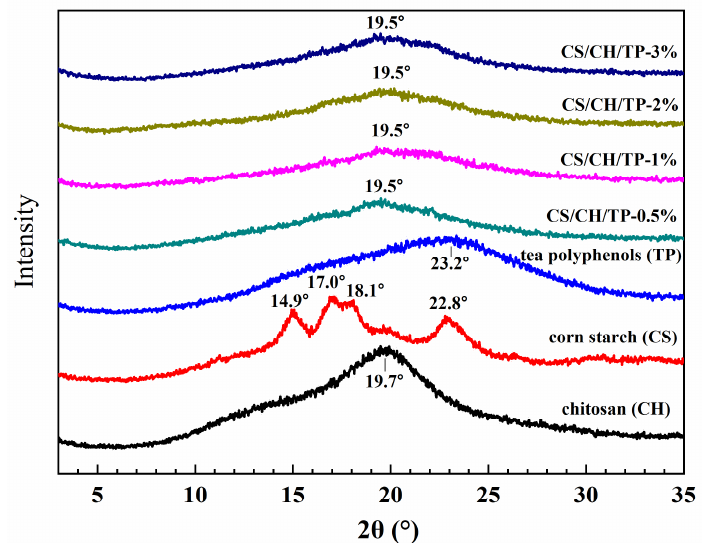
Figure 3. X-ray diffraction patterns of CS film, CH film, tea polyphenols and CS/CH/TP films.